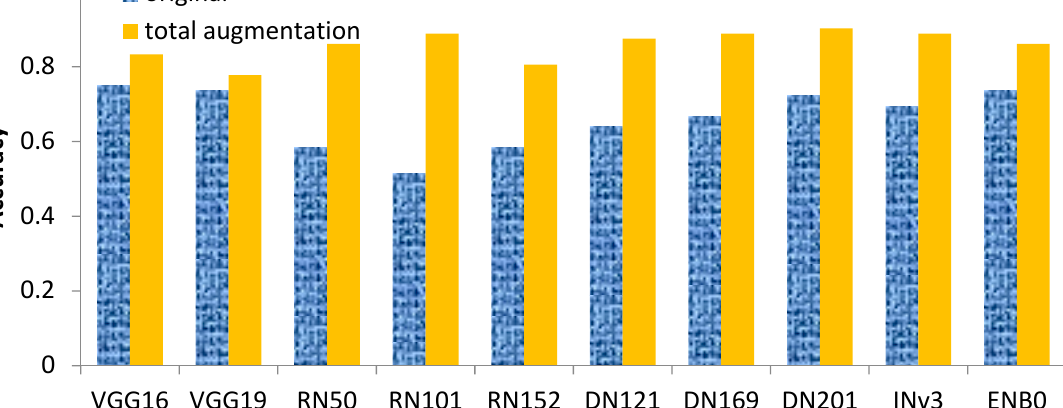
Figure 10. Accuracies of different models with or without data augmentations.